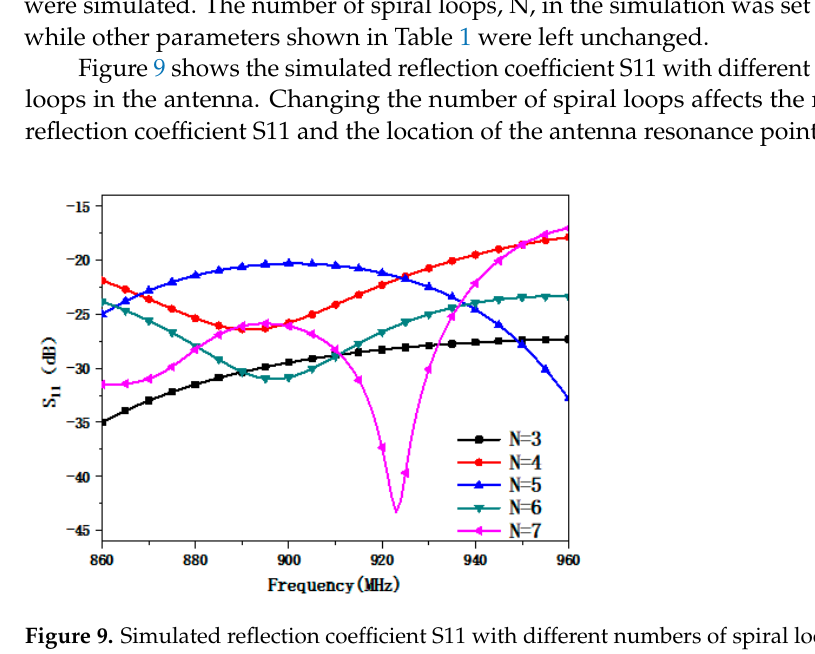
8 of 19 Figure 8. Simulation of the distribution of the electric field component Ey at different heights. 3.4. Parametric Analysis